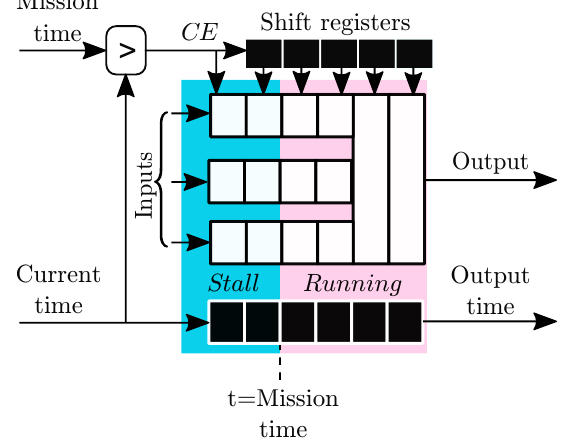
Figure 4. Pipeline stall during SAN model state